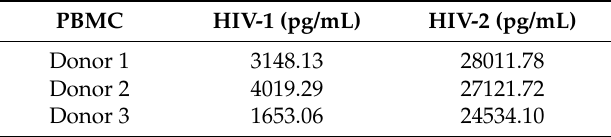
Table 1. Quantification of human immunodeficiency virus type 1 (HIV-1) (P-24) and 2 (HIV-2) (P-27)